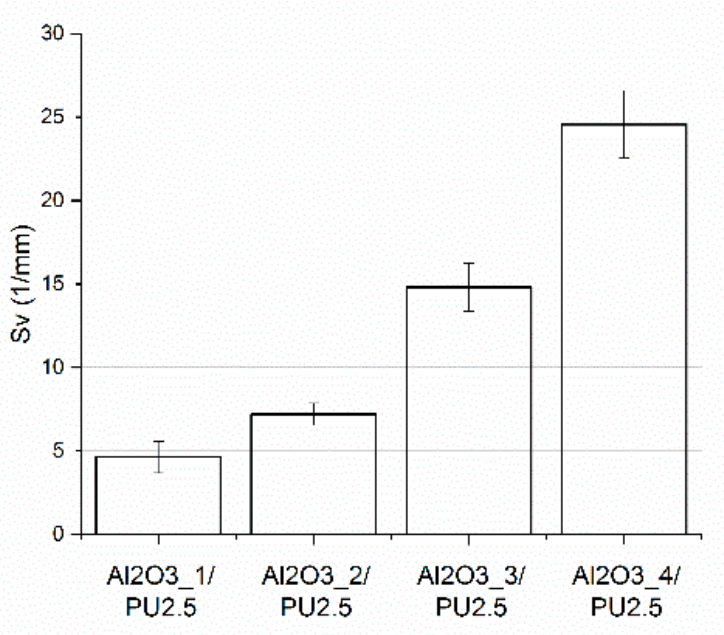
of the interphase boundaries of Al O _1/PU2.5, v 2 3 O _4/PU2.5 composites. 2 3